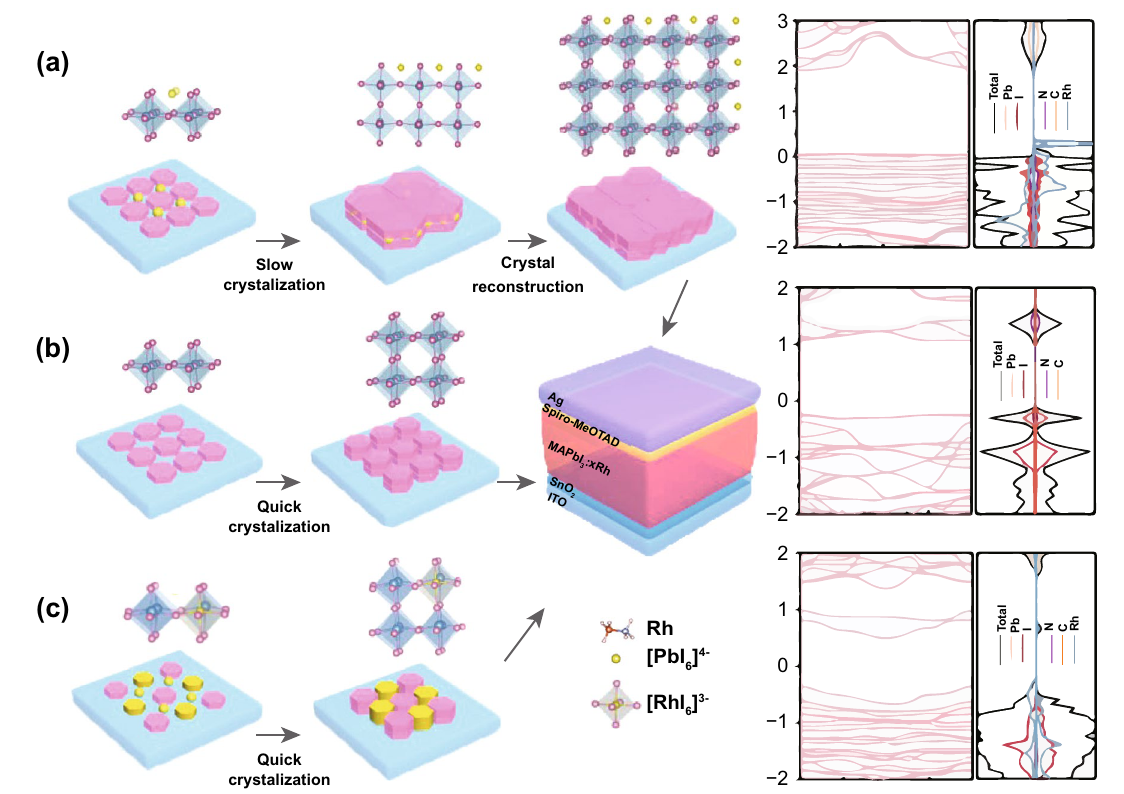
Fig. 2 Schematic plot of mechanism for Rh 3+ ‑induced perovskite crystallization. a 1% Rh 3+ ‑incorporated in MAPbI 3 through Rh‑N band and Rh‑I band to form large crystalline structure. b Pristine MAPbI 3 film formed by quick crystallization. c 5% Rh 3+ ‑incorporated in MAPbI 3 film. The diagram on the right is the corresponding band structures and density of states from the first principles ( a interstitial 6% Rh incorporation, b MAPbI 3 , c MAPb 0.875 Rh 0.125 I 3